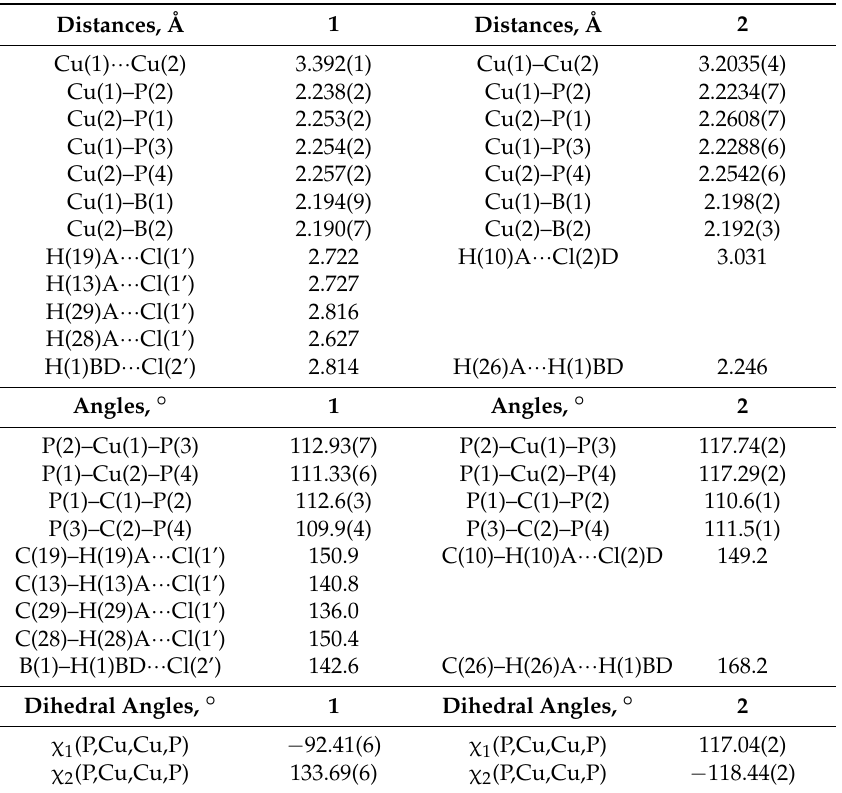
Table 3. Selected structural parameters for 1 and 2 .